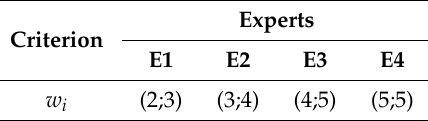
Table 1. Experts’ evaluation of criterion w i .